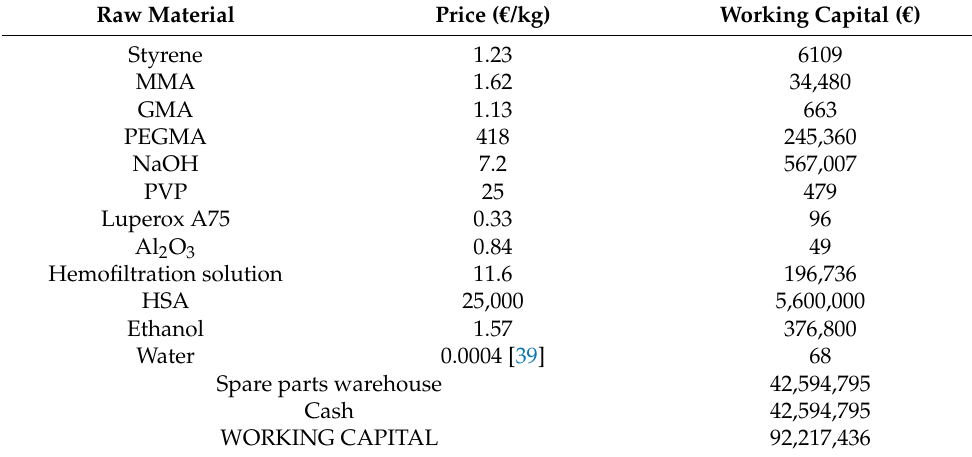
Table 9. Price of the raw